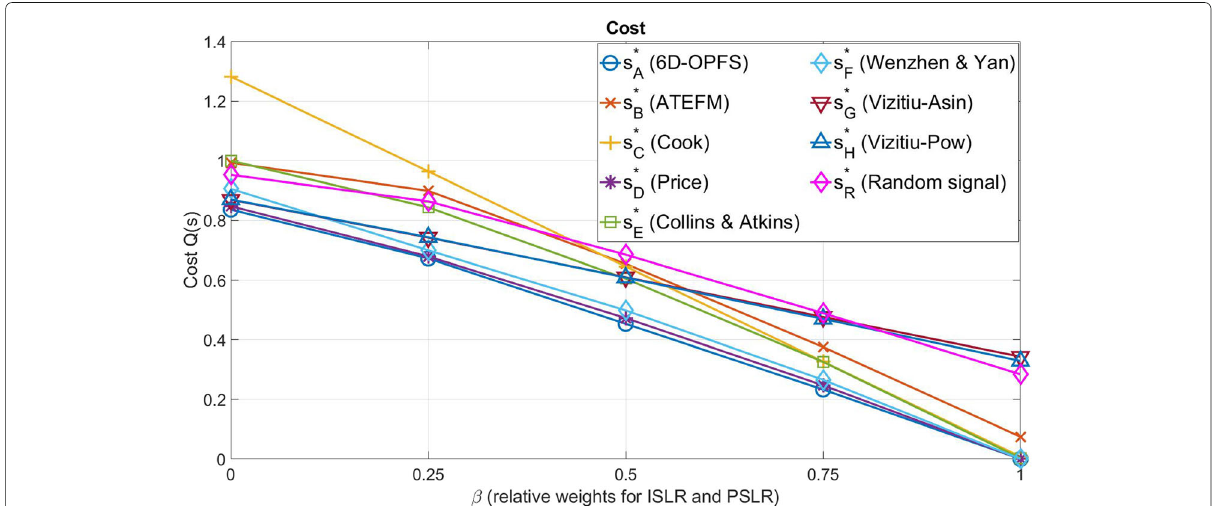
Fig. 5 Performance curves are labeled s ∗ randomly generated signals of Section